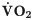
Correlations of the increases in V˙O2 with respiratory rate (A), tidal volume (B), minute ventilation (C), heart rate (D), stroke volume (E), cardiac output (F), and arterial-venous oxygen difference (G) from rest to peak exercise.